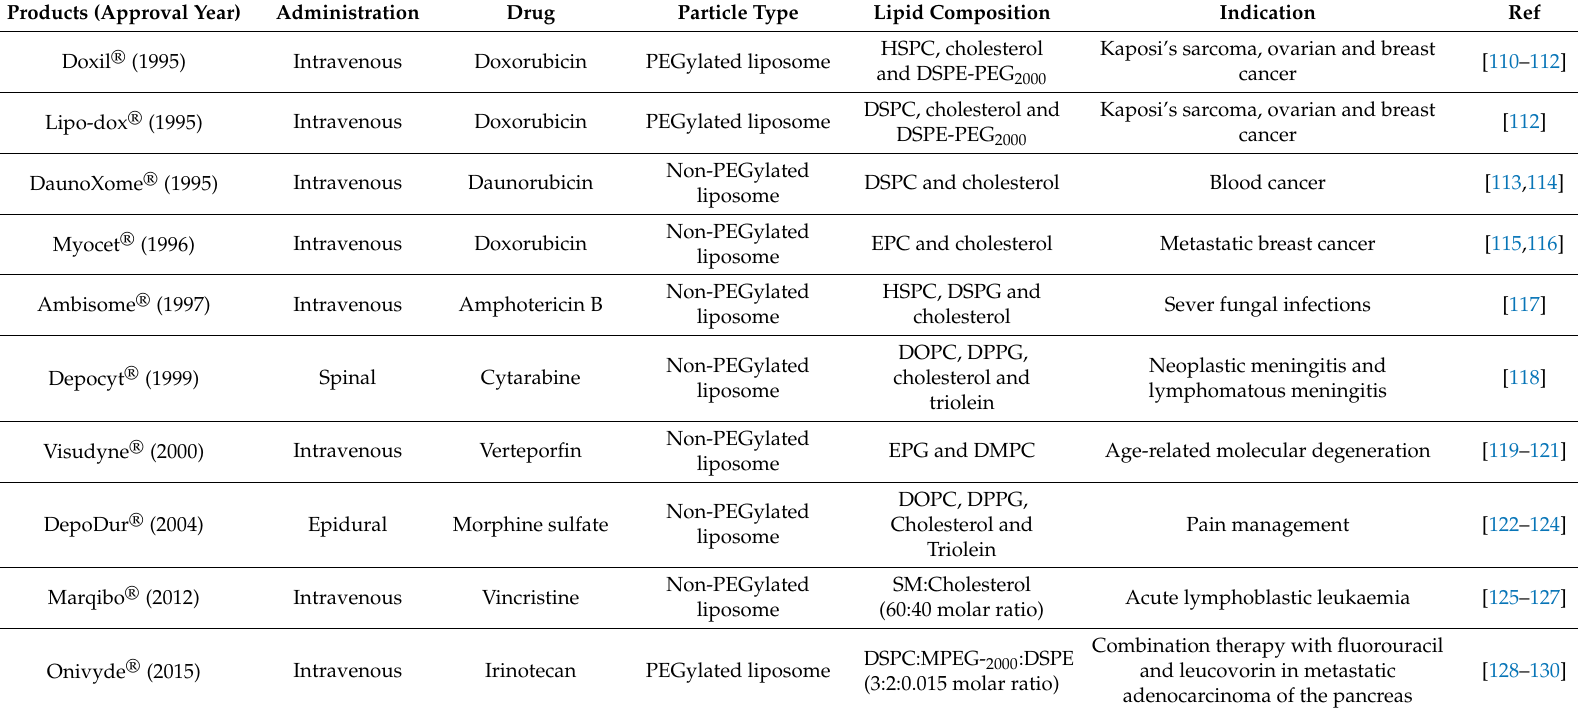
Table 2. Liposomal commercialized products in USA market. (Data from US FDA